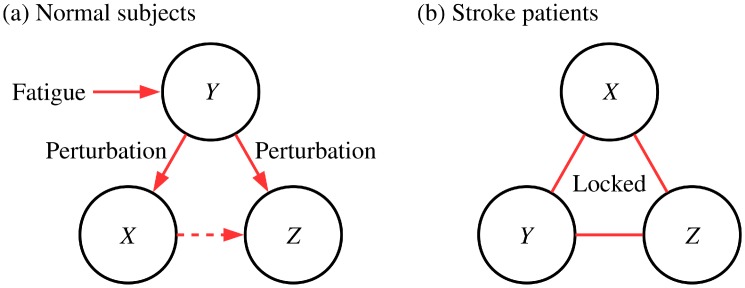
Schematic diagrams of the arm-posture dynamics.Shown in (a) and (b) are schematic diagrams describing the conceptual coupling structures of normal subjects and stroke patients, respectively.